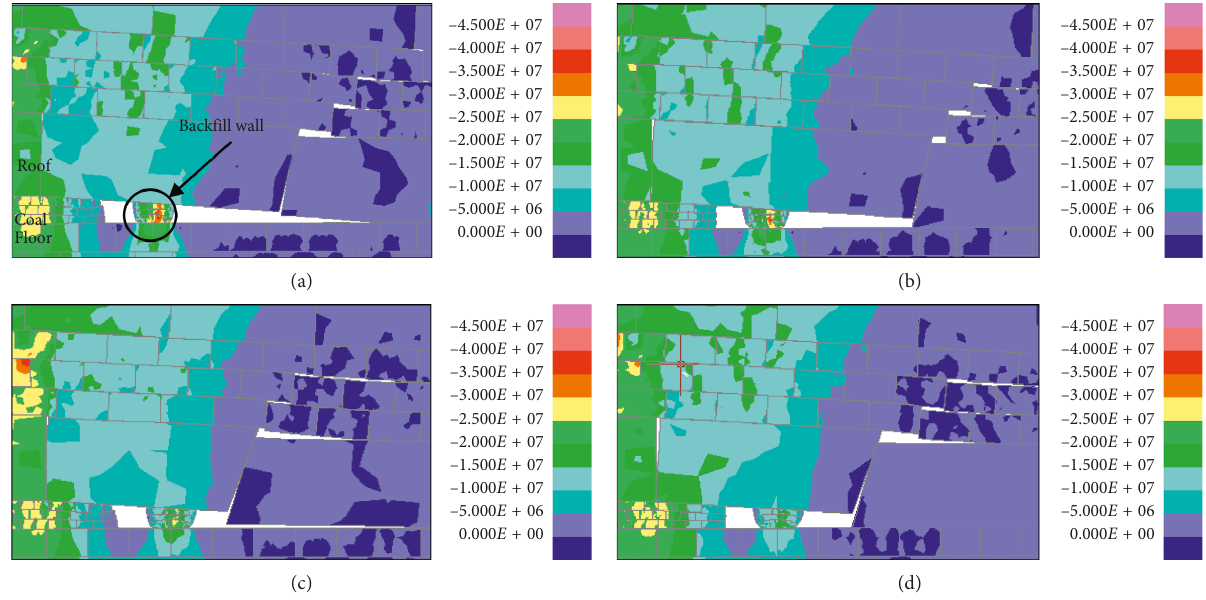
Figure 10: Stress distribution of surrounding rock before and after the THAS formation. (a) Cutting angle 10 ° and position 11m, (b) cutting angle 10 ° and position 13m, (c) cutting angle 15 ° and position 3m, and (d) cutting angle 15 ° and position 5m.